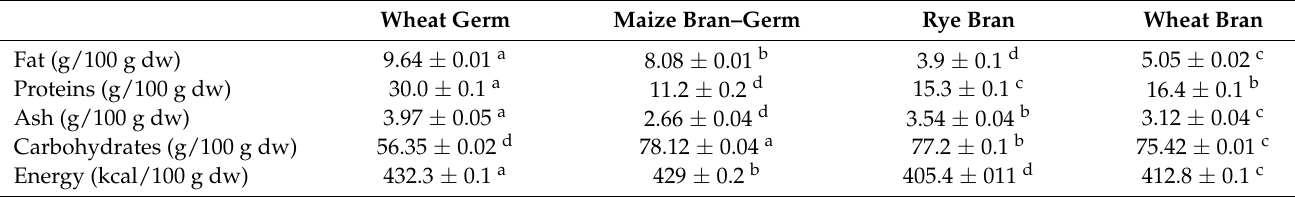
Table 1. Proximate composition and energy value of the cereal